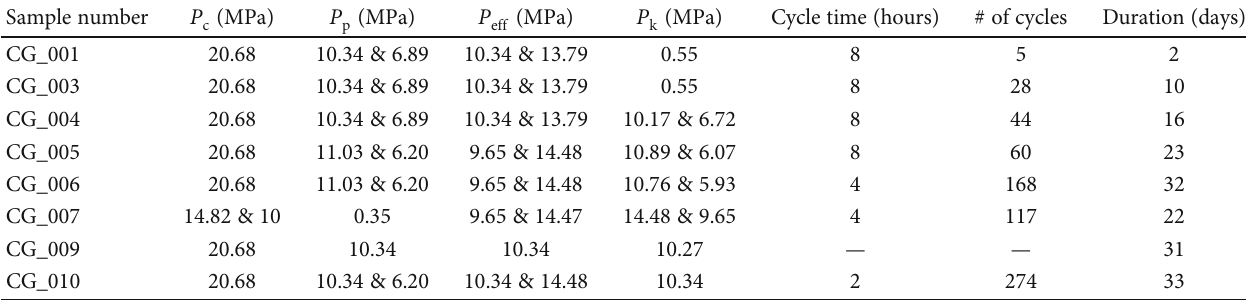
Figure 3: Model of stress-strain evolution over time during cyclic loading tests: (a) plot of con fi ning pressure ( P test duration; (b) plot of axial ( ε ax ), radial ( ε rad ), and volumetric ( ε v ) strains over test duration. Table 2: Testing conditions for each hydrostatic loading test. Tests with multiple pressure conditions indicate maximum and minimum pressure of each cycle. P c =con fi ning pressure; P p =pore pressure; P eff =e ff ective pressure during cycles; P k =e ff ective pressure